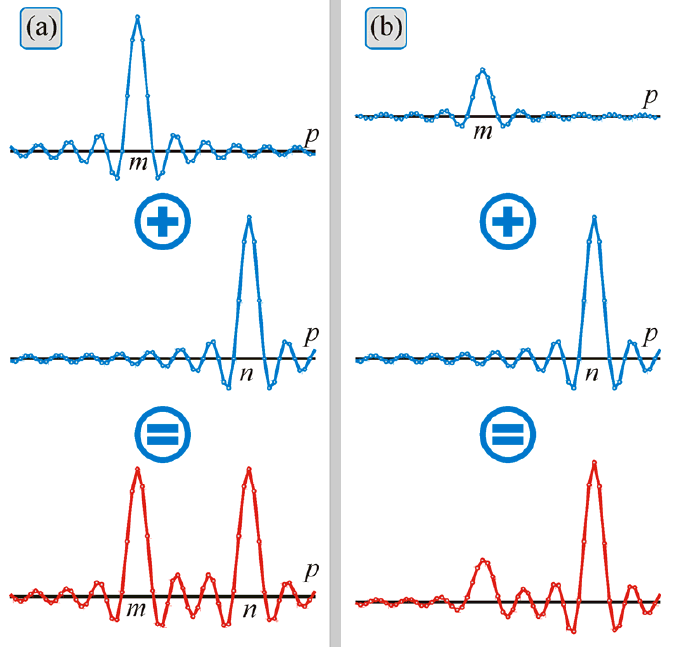
Figure 3. OAM spectrum of two optical vortex beams passed through a sector aperture, when the incident beams are of the same energy ( a ) and of different energy ( b ).